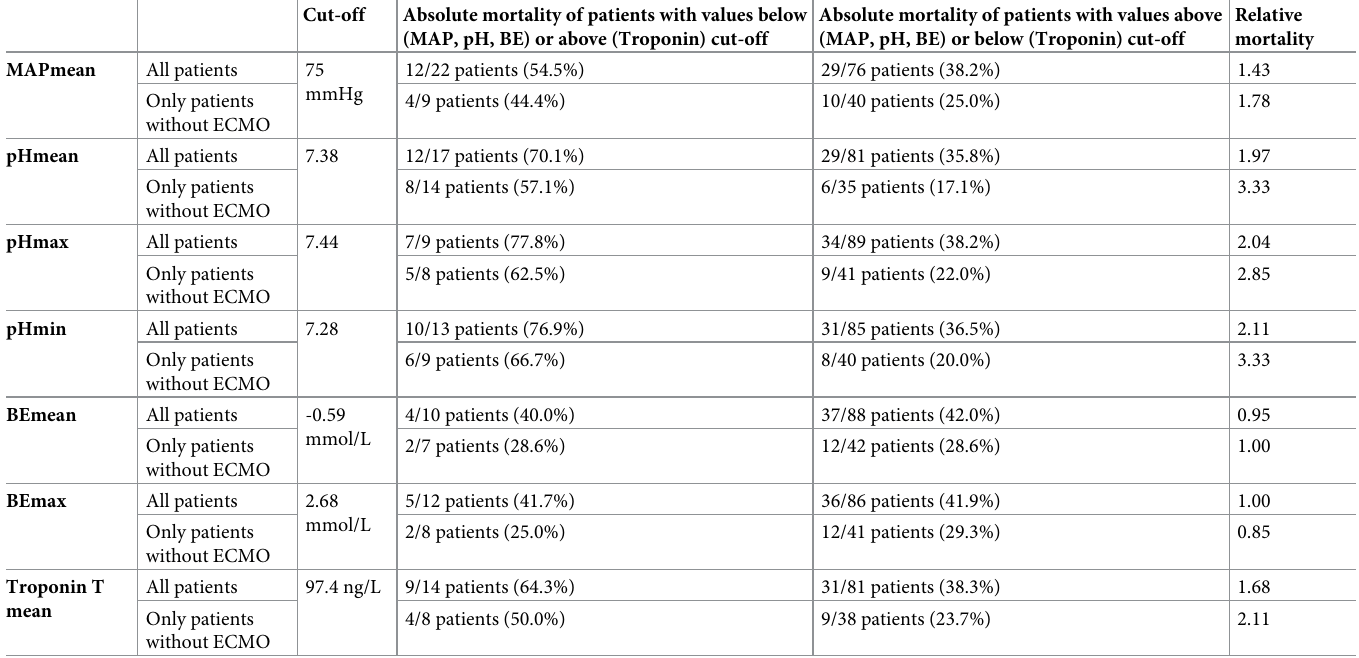
Table 1. Relative mortality in the second-wave cohort (univariable analysis). Using the cut-off values for a survival probability of 50%, which had been determined for the patients of the first-wave cohort by univariable regression analysis, the second-wave cohort was divided into two groups: patients with values above and patients with values below the cut-off. Mortalities within the groups and, from these results, the relative mortality was calculated. MAPmean, mean MAP during the 14-day observation period for each patient; pHmean/pHmax/pHmin, mean, maximum, and minimum pH of blood during the 14-day observation period for each patient; BEmean/BEmax, mean and maximum BE during the 14-day observation period for each patient; Troponin Tmean, mean troponin T during the 14-day observation period for each patient. Cut-off Absolute mortality of patients with values below Absolute mortality of patients with values above Relative (MAP, pH, BE) or above (Troponin) cut-off (MAP, pH, BE) or below (Troponin) cut-off